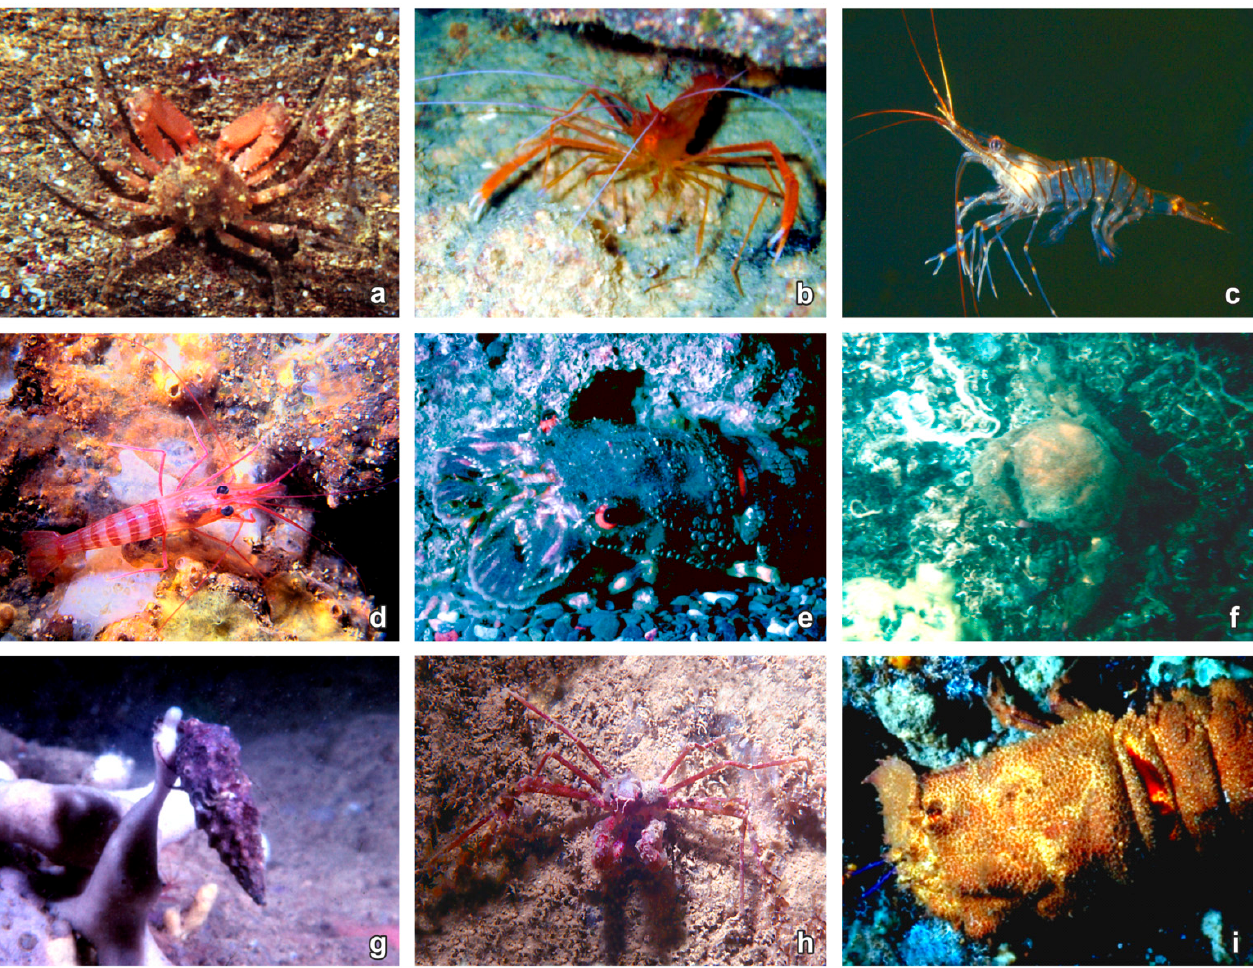
Figure 8. Underwater photographs of decapod species in the Grotta Marina of Bergeggi: ( a ) Herbstia condyliata ; ( b ) Stenopus spinosus ; ( c ) Palaemon serratus ; ( d ) Lysmata seticaudata ; ( e ) Scyllarus arctus ; ( f ) Dromia personata ; ( g ) Clibanarius erythropus (in a shell of Cerithium vulgatum ); ( h ) Inachus dorsettensis ; ( i ) Scyllarides latus .